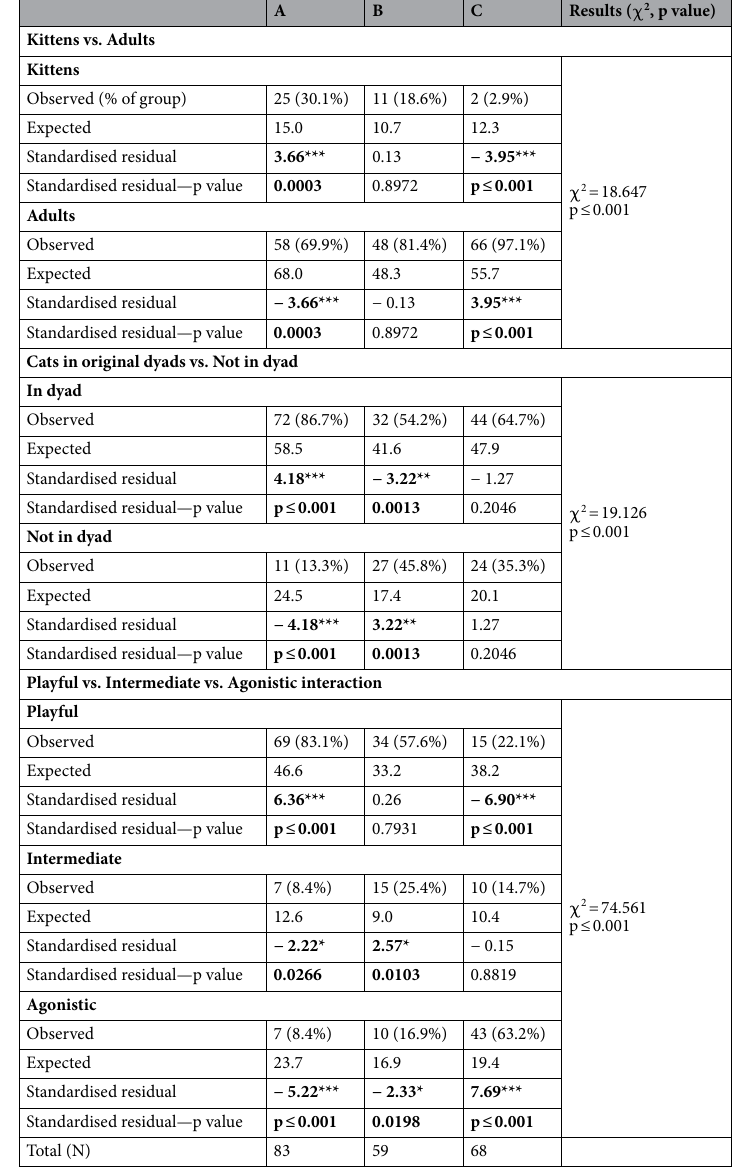
Table 4. Pearson chi-square tests for categorical variables of higher level of hierarchical analysis’s clusters 2 d.f., *p ≤ 0.05, **p ≤ 0.01, ***p ≤ 0.001. Significant values are in